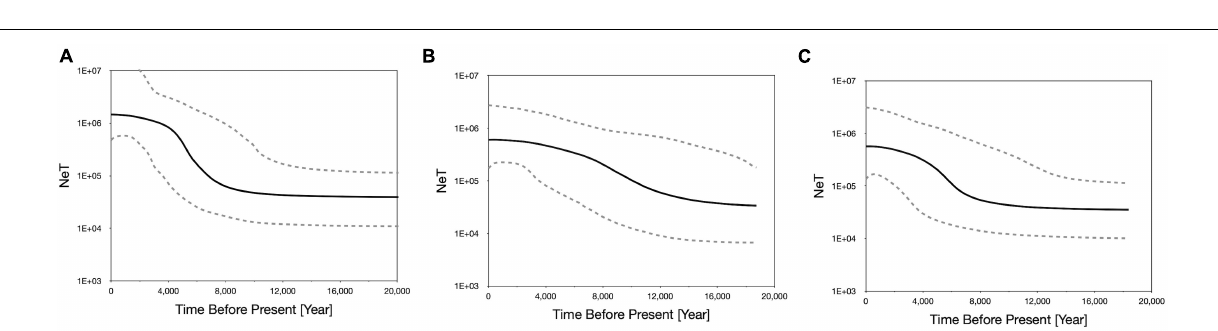
FIGURE 3 | Mismatch distribution of (A) overall Eriphia ferox under investigation; Eriphia ferox populations in (B) Japan, (C) Taiwan (Mainland), (D) Taiwan (Penghu), (E) Malaysia, and (F) Singapore. The solid red line represents observed frequency and the dashed blue line specifies modeled frequency.